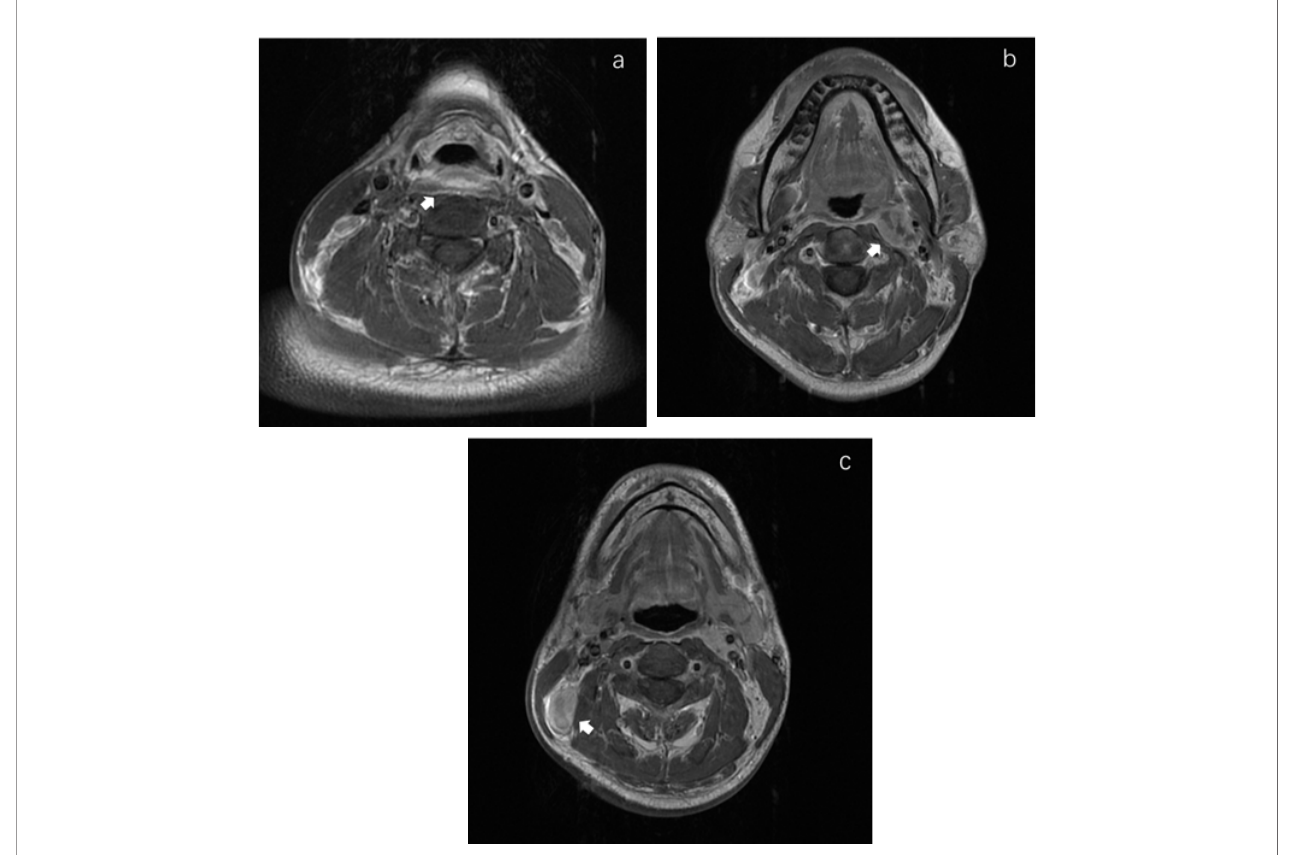
FIGURE 3 | MRI images in T1 with contrast of a posterior wall cancer patient. (A) The primary focus of posterior wall cancer. (B) The left retropharyngeal lymphnode metastasis. (C) The metastatic lymphnode in right Level II.